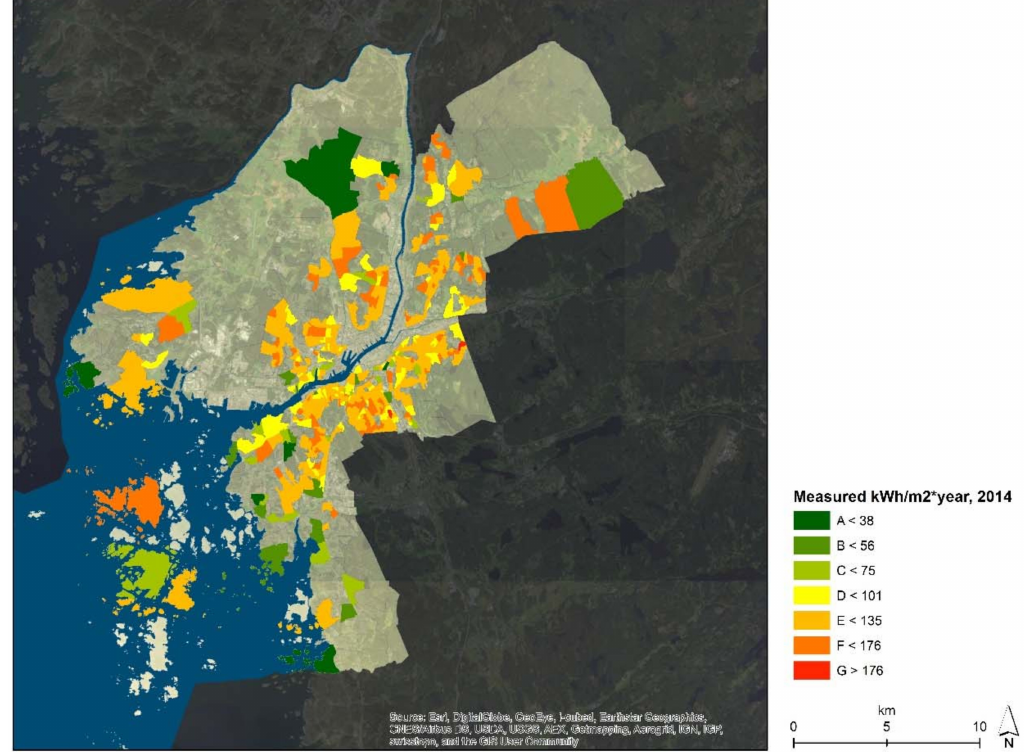
Figure 4. Measured energy use per m 2 HFA in the building stock aggregated to base